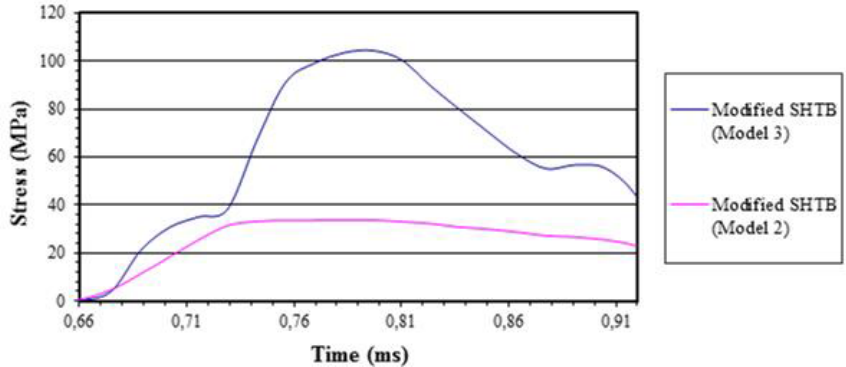
Figure 12. Transmitted stress-time curves in the centre of the SiC-reinforced ZC71 magnesium alloy specimen pertinent to both modified